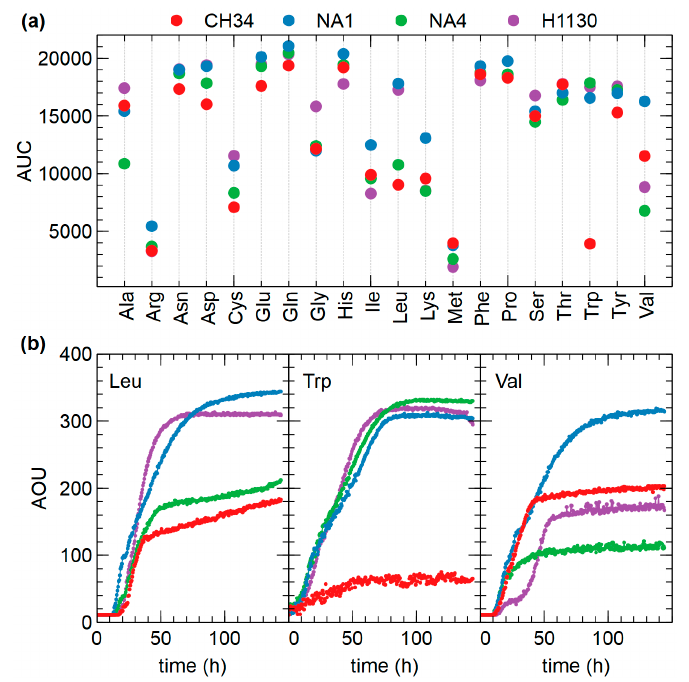
Figure 12. ( a ) Overview of OmniLog phenotypic assays with amino acids as N source (AUC = area under the curve) for C. metallidurans CH34, NA1, NA4 and H1130, ( b ) Growth kinetics in the presence of L-leucine, L-tryptophan and L-Valine as N source (AOU = arbitrary OmniLog units).